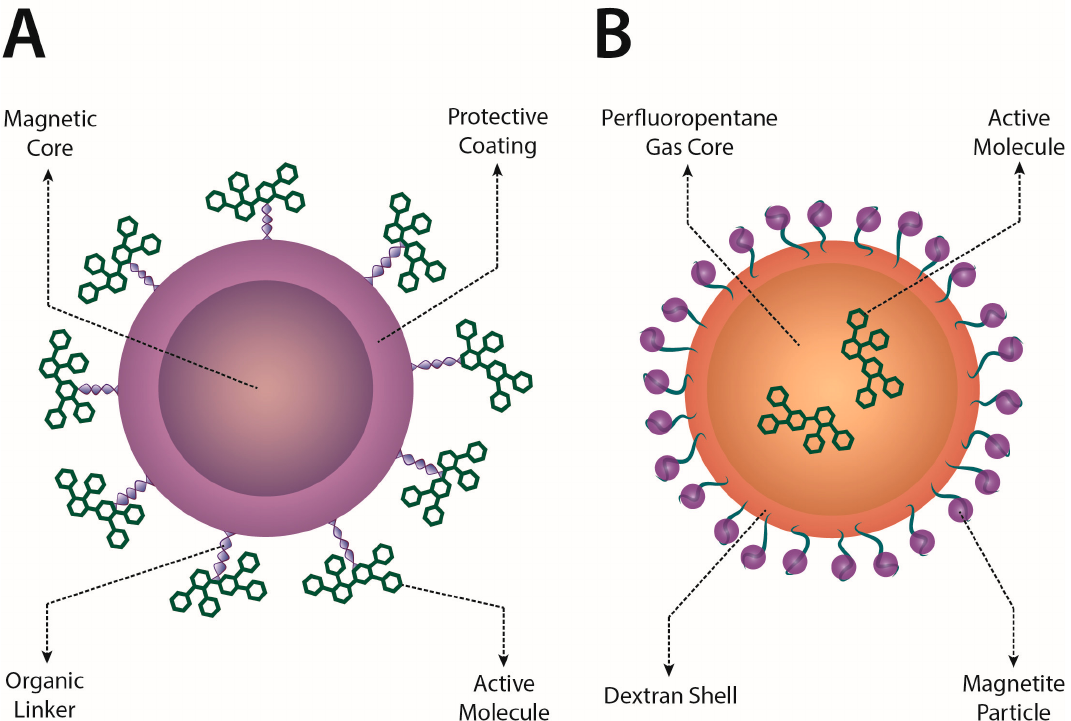
Figure 1. Schematic representation of two strategies for drug delivery through magnetic nano-carriers. ( A ) The magnetic element is the core of the nanoparticles, while the active compound is linked to the protective coating surfacing the core; ( B ) In this case, the magnetic element consists of a number of iron nanoparticles attached to the surface of a nano-bubble structure that can be internally loaded with drug compounds.